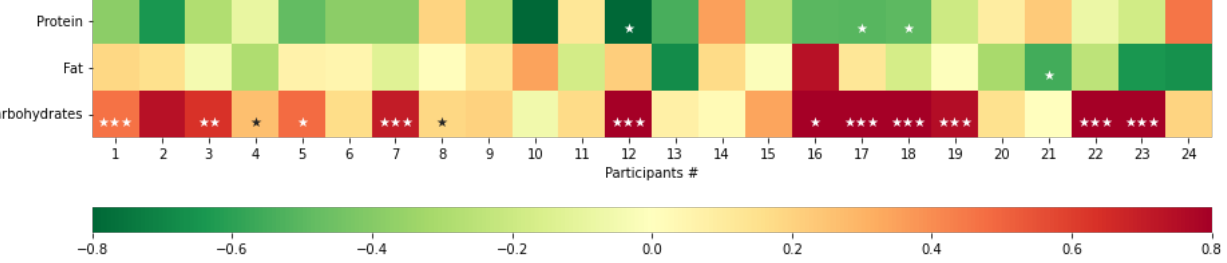
Figure 1. Identification of individual differences. Heatmap of regression coefficient from multivariate regression analysis on 24 patients, all of whom had at least 28 meals annotated with nutrition values. The number of stars (* p ≤ 0.05, ** p ≤ 0.01, *** p ≤ 0.001) represent significance of the linear relationship between nutrient and maximal glucose level (gmax). The value of the regression coefficient (colour) represents the strength of the positive/negative correlation between each nutrient and gmax. A red colour indicates that the increase in glucose level is more pronounced if the amount of the relevant macronutrient increases in the meal when controlling for the amount of other macronutrients.